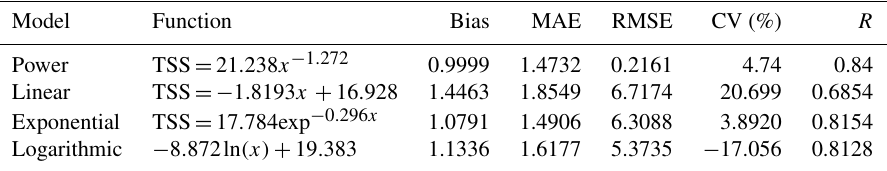
Table 2. Calibration and accuracy assessment of the newly derived MODIS Aqua models in this study for TSS estimations tested using various model functions. Calculation for bias, MAE, and RMSE use a log transformation of the data prior to calculation of error metric measurements, as adapted from Seegers et al. (2018) and Balasubramanian et al. (2020). The band ratio Rrs ( 530 )/ Rrs ( 666 ) is established as function x . The power function model is selected based on low performance metric values.